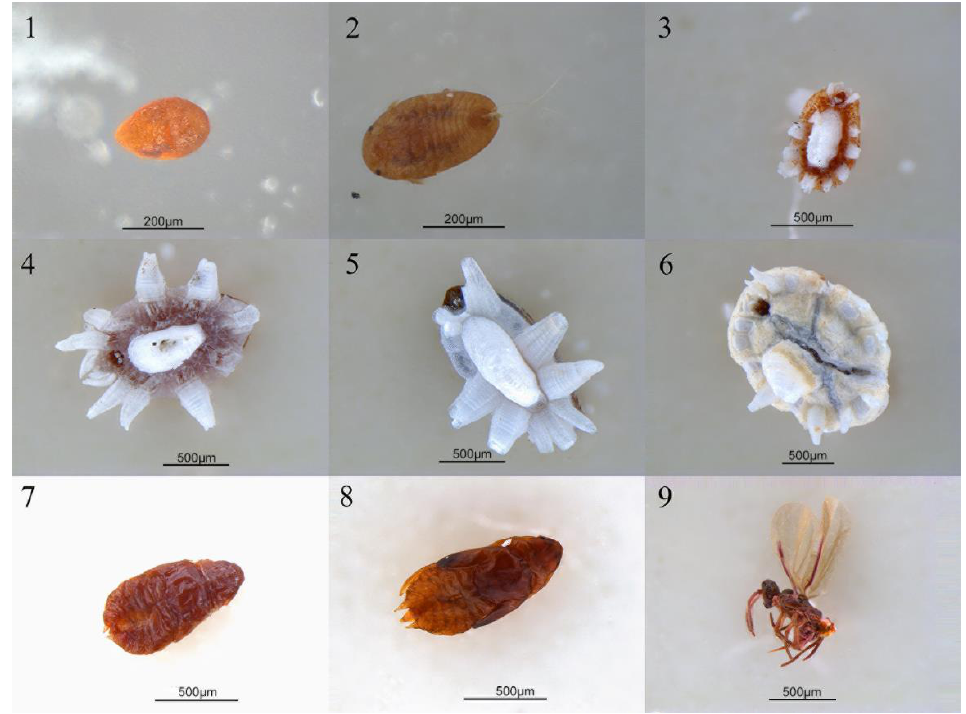
Figure 1. The photos of Ceroplastes japonicus at nine developmental stages. 1. Egg; 2. new nymph; 3. first instar nymph; 4. second instar female nymph; 5. second instar male nymph; 6. third instar female nymph; 7. prepupa; 8. pupa; 9. male adult.